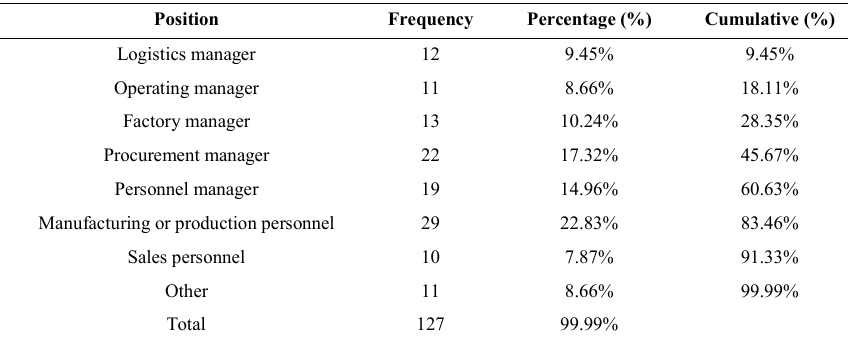
Table 1. Position in organization.